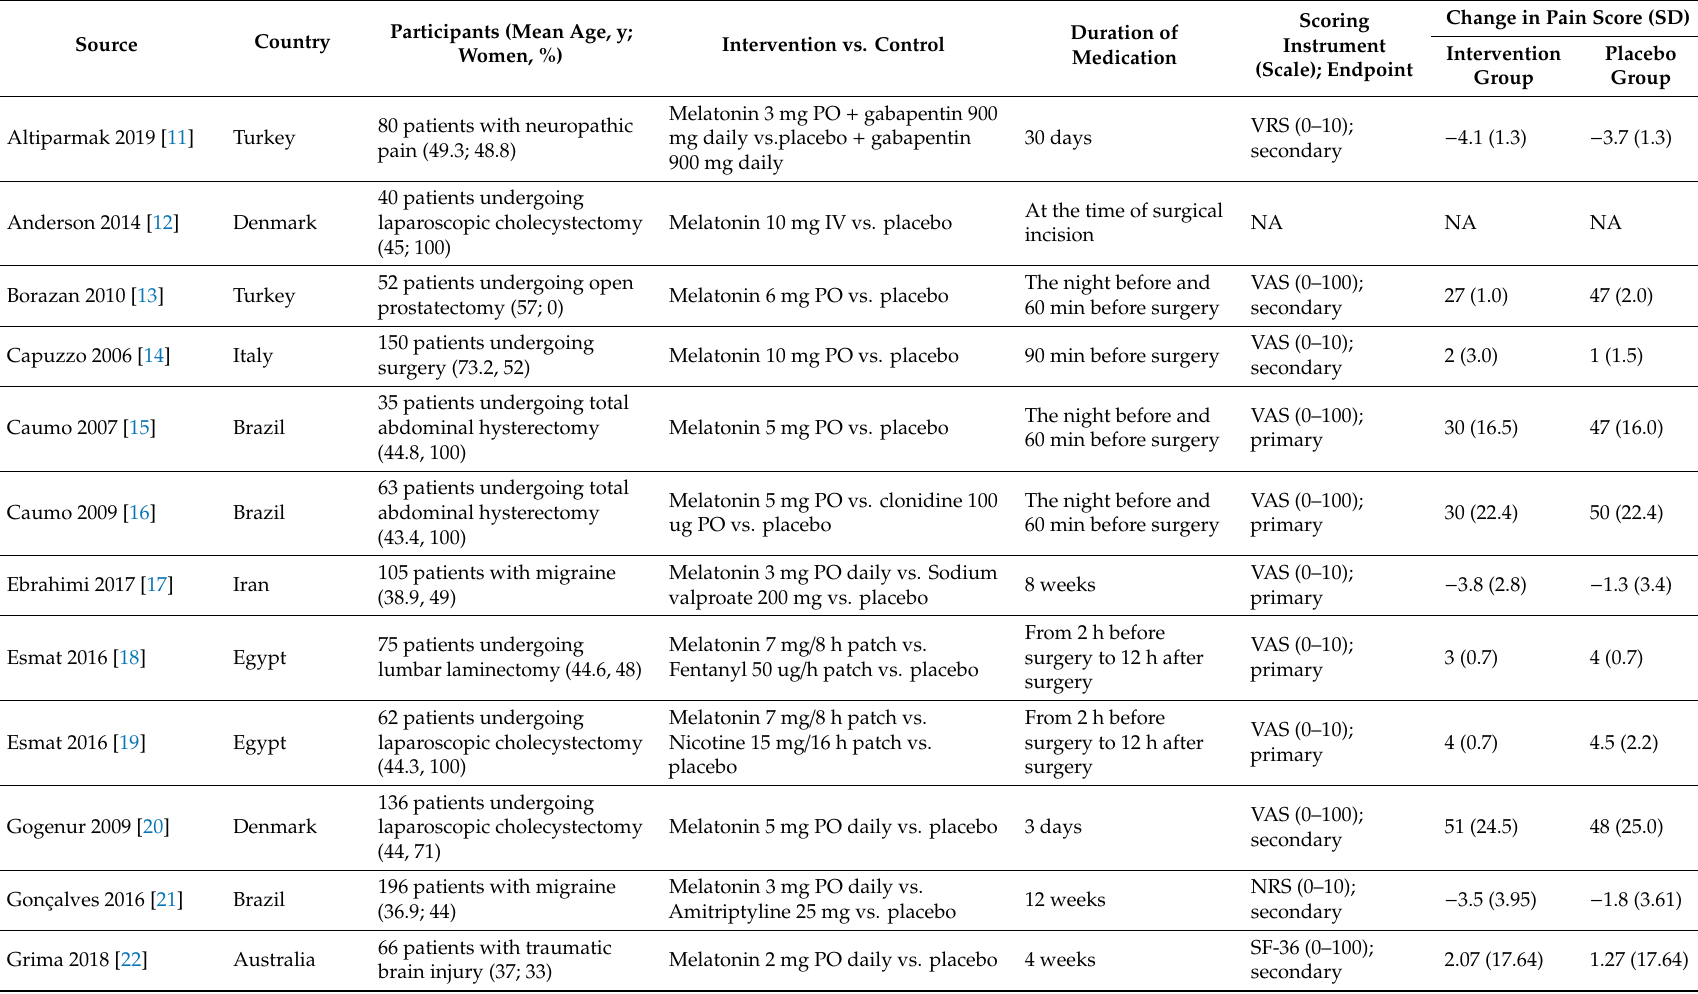
Table 1. General characteristics of randomized, double-blind, placebo-controlled trials included in the final